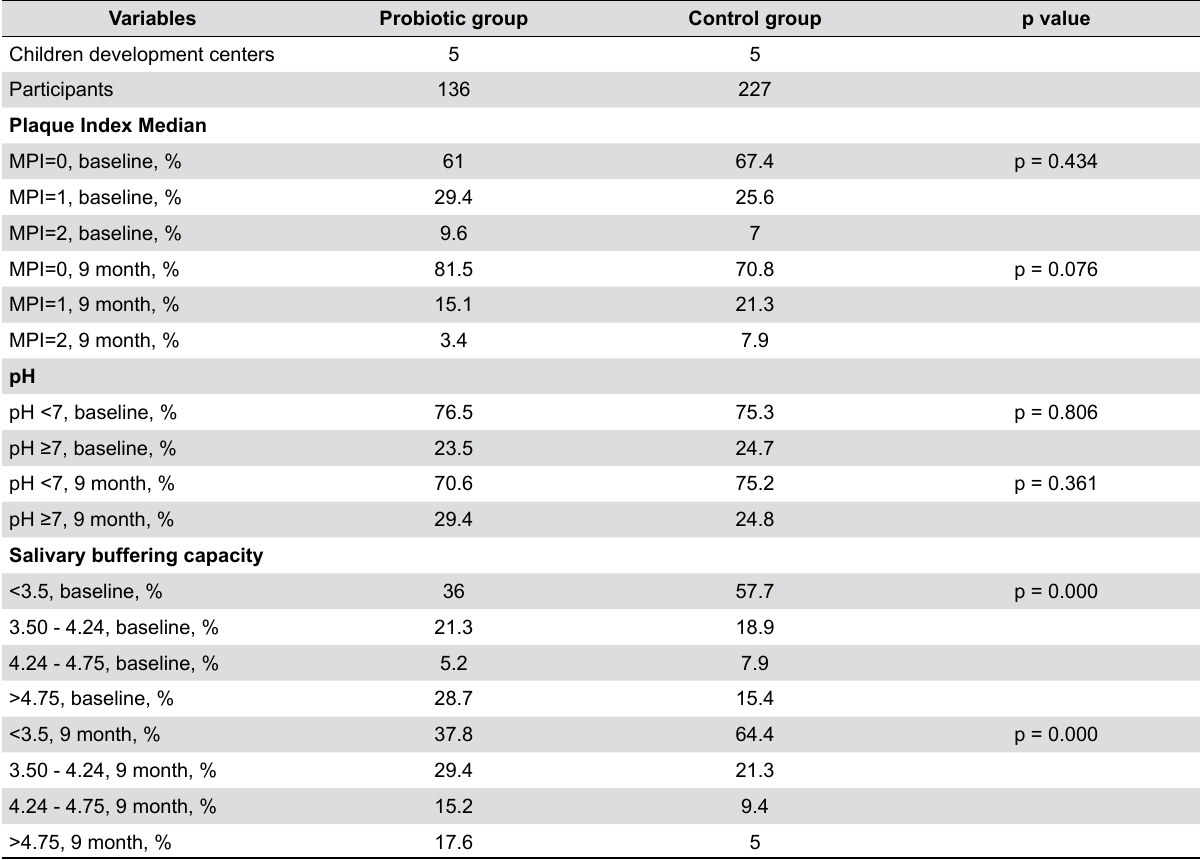
Table 3- Dental plaque, pH, and salivary buffer capacity in the probiotic group and control group at baseline and at 9 months of study